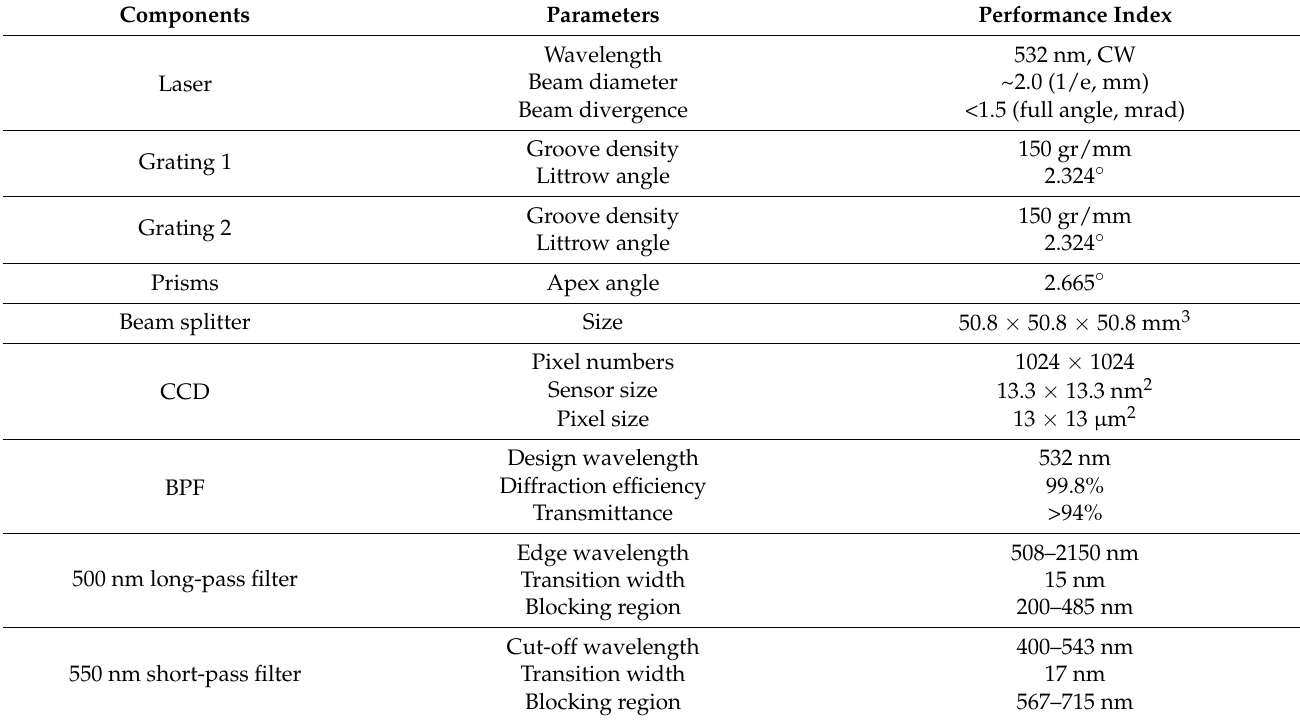
Figure 2. Spatial heterodyne THz Raman spectrometer. Table 1. Key parameters of components used in the experimental breadboard.